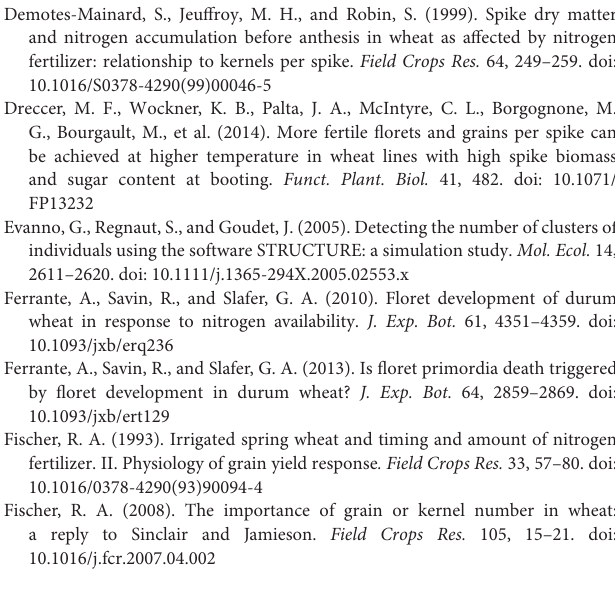
Figure S4 | The grain number of the apical and basal spikelets among different environments in series of cultivars named Yangmai and Ningmai. Table S1 | Information of 220 wheat accessions used in this study. Table S2 | Pearson’s correlation coefficients between phenotypic traits in the different environments. Table S3 | Allele number, MAF, and PIC of 106 polymorphic SSR markers detected in the association panel. Table S4 | Favorable alleles and genetic effects of 56 SSR loci significantly ( P < 0.01 ) associated with seven phenotypic traits. Table S5 | The number of favorable alleles carried by 220 wheat accessions used in this